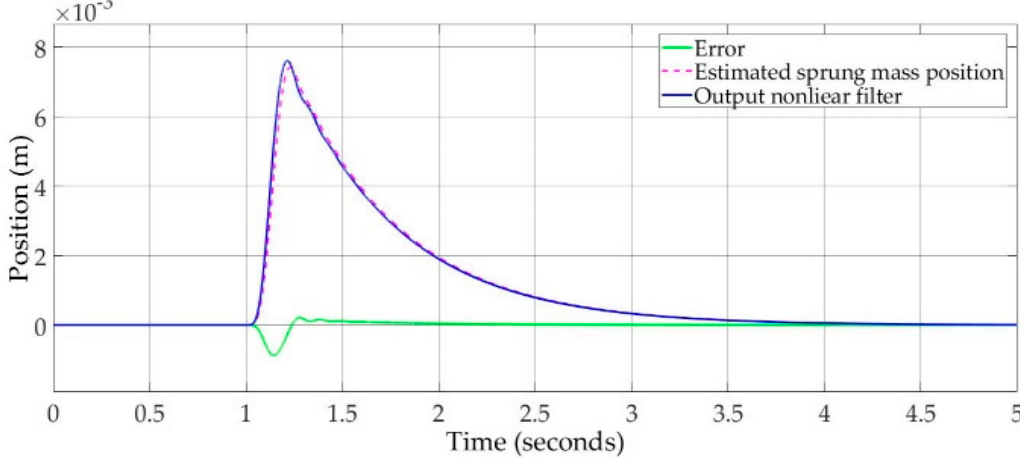
Figure 5. The system response of the NAC system.